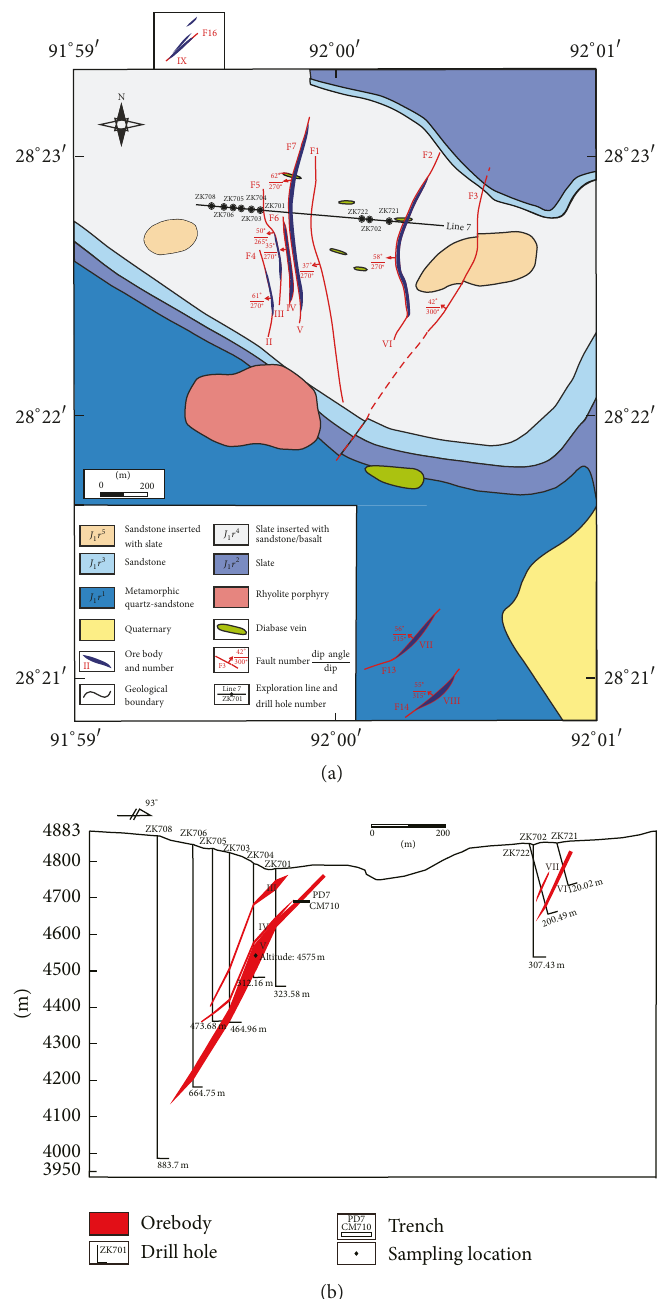
Figure 2: (a) Geological map of the Zhaxikang Sb-Pb-Zn-Ag polymetallic deposit (modified from Zheng et al. [7]). (b) Cross-section along Exploration Line 7. 𝐽 1 𝑟 1 to 𝐽 1 𝑟 5 : the first to fifth lithologic section of the Lower Jurassic Ridang